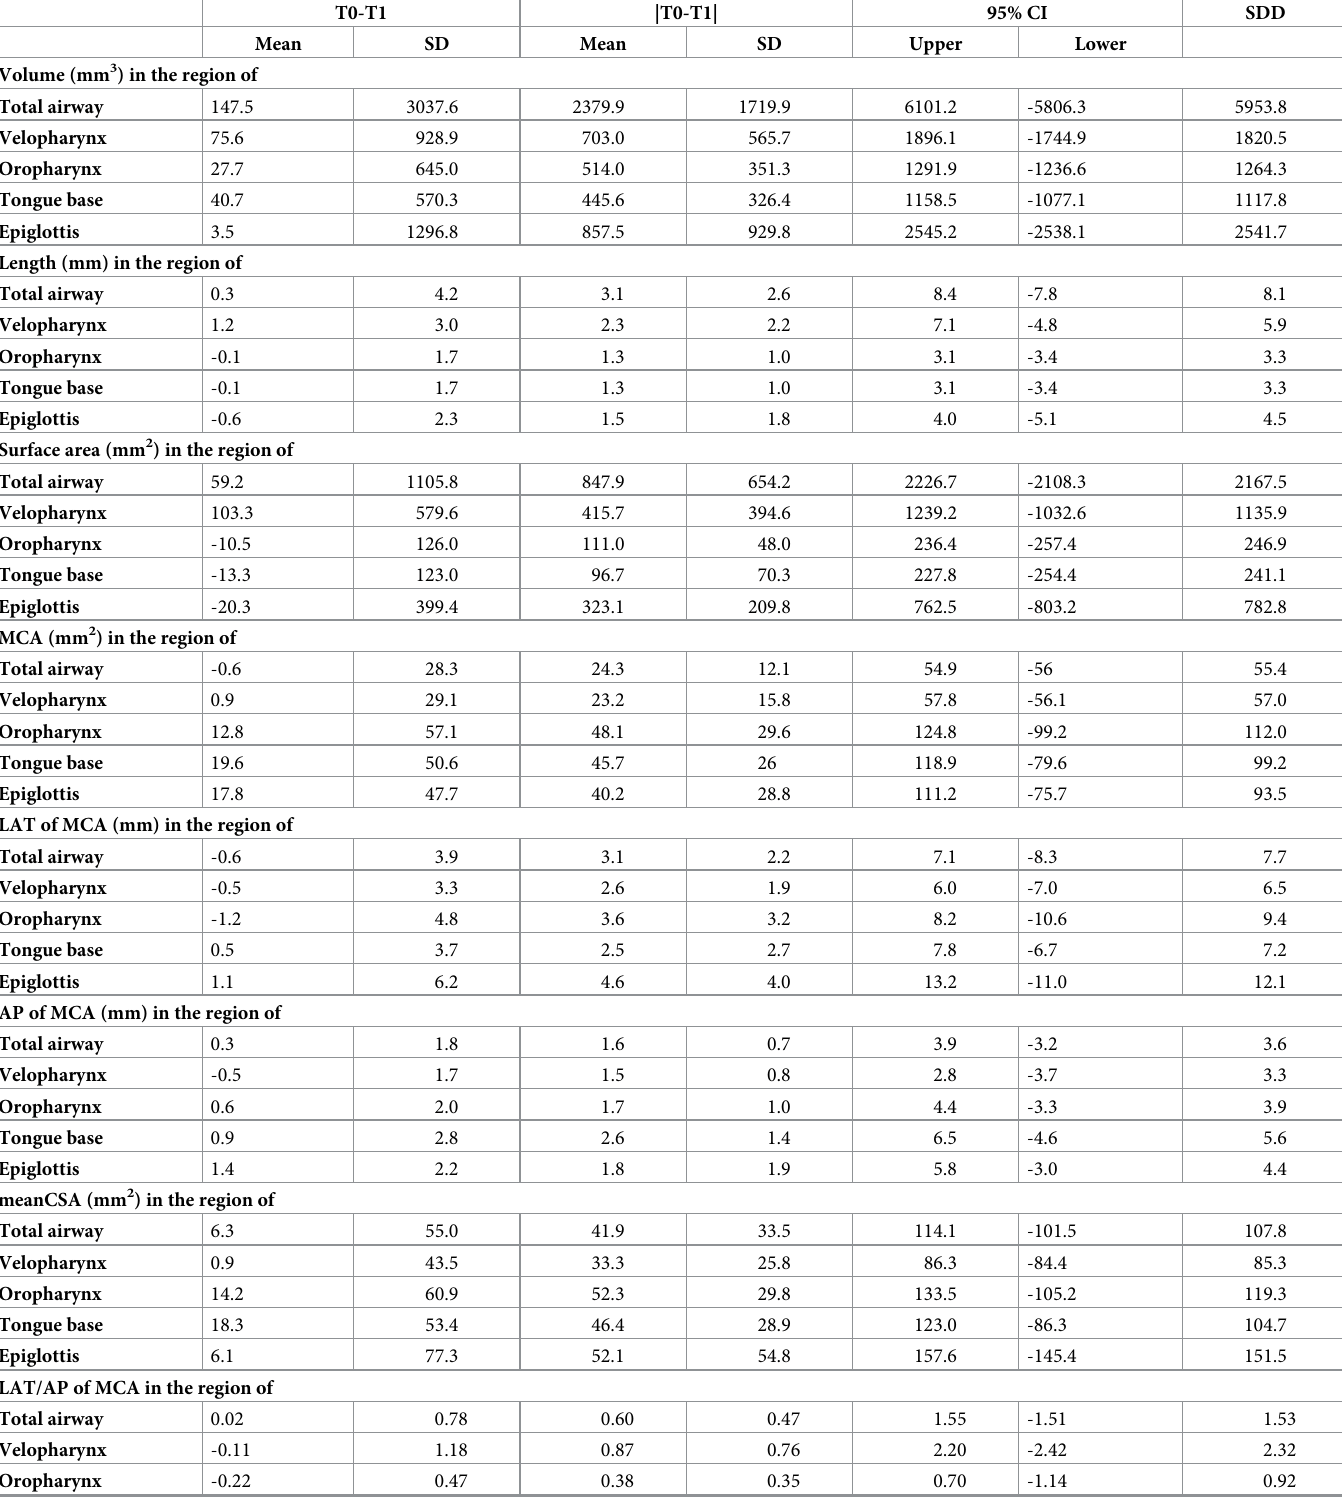
Table 3. Bland-Altman analysis of difference between two scans (T0 and T1) (N =